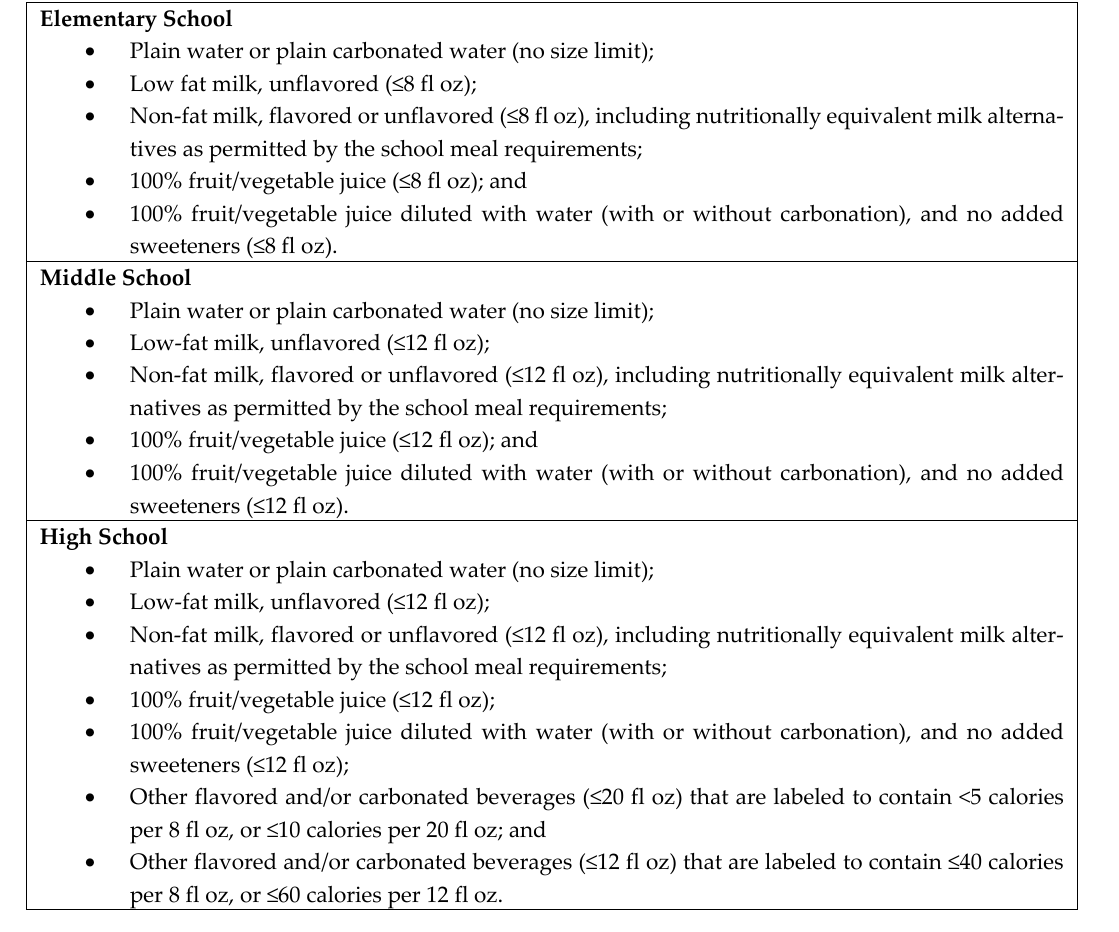
Figure 1. Beverages Allowed as Part of the U.S. Department of Agriculture’s Smart Snacks in School Standards [34,35].